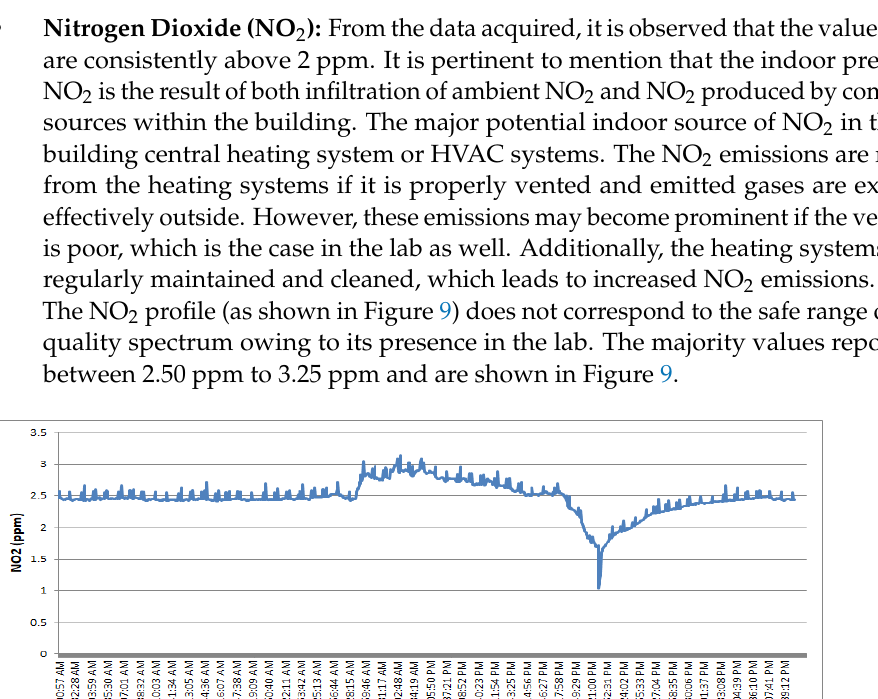
Figure 8. Variation in Concentration of CO over a period of 24 h.